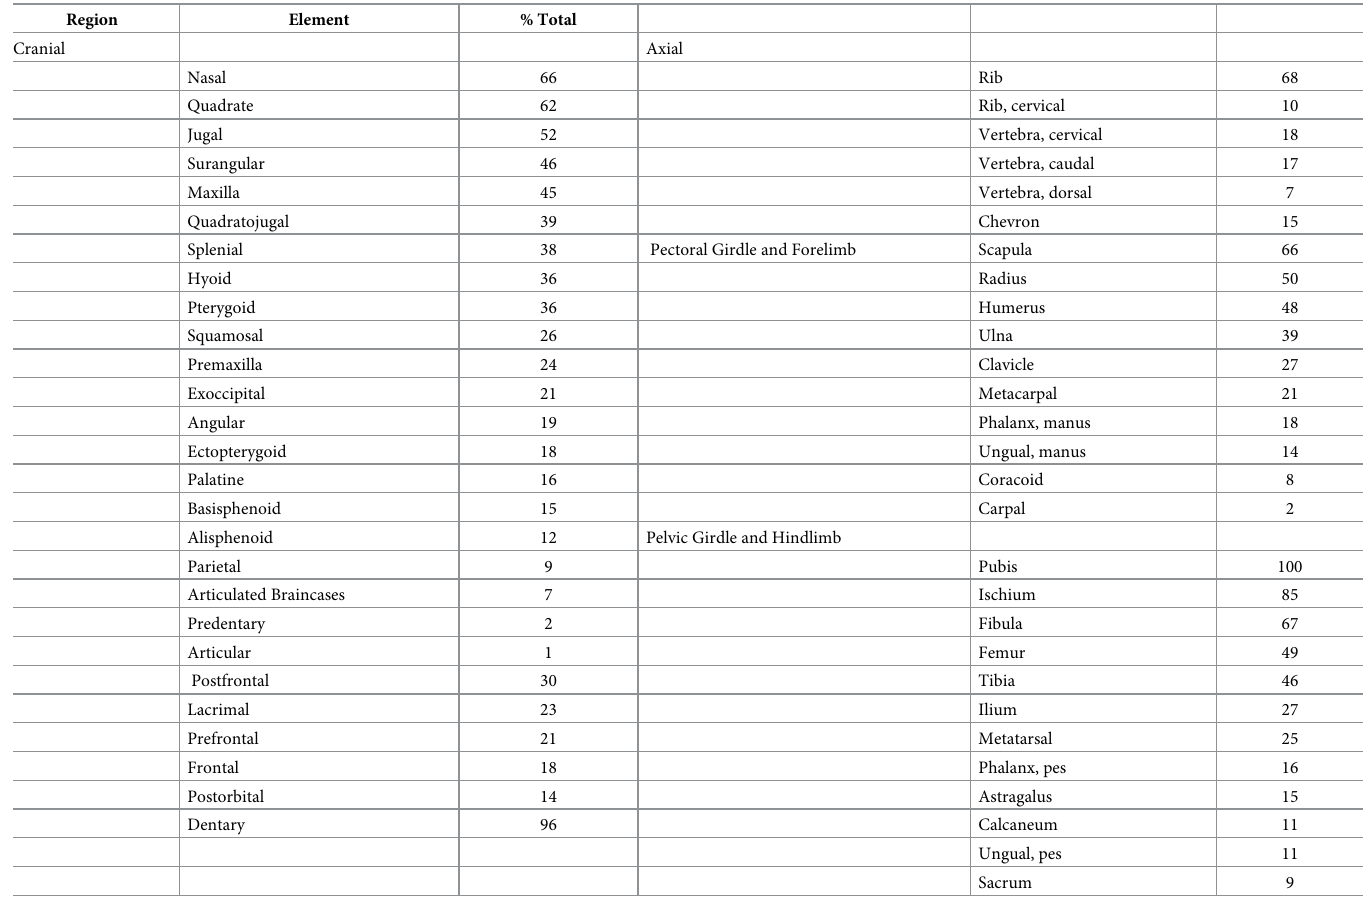
Table 3. Percentages of bones recovered based on MNI of 61, sorted by abundance. Region Element % Total